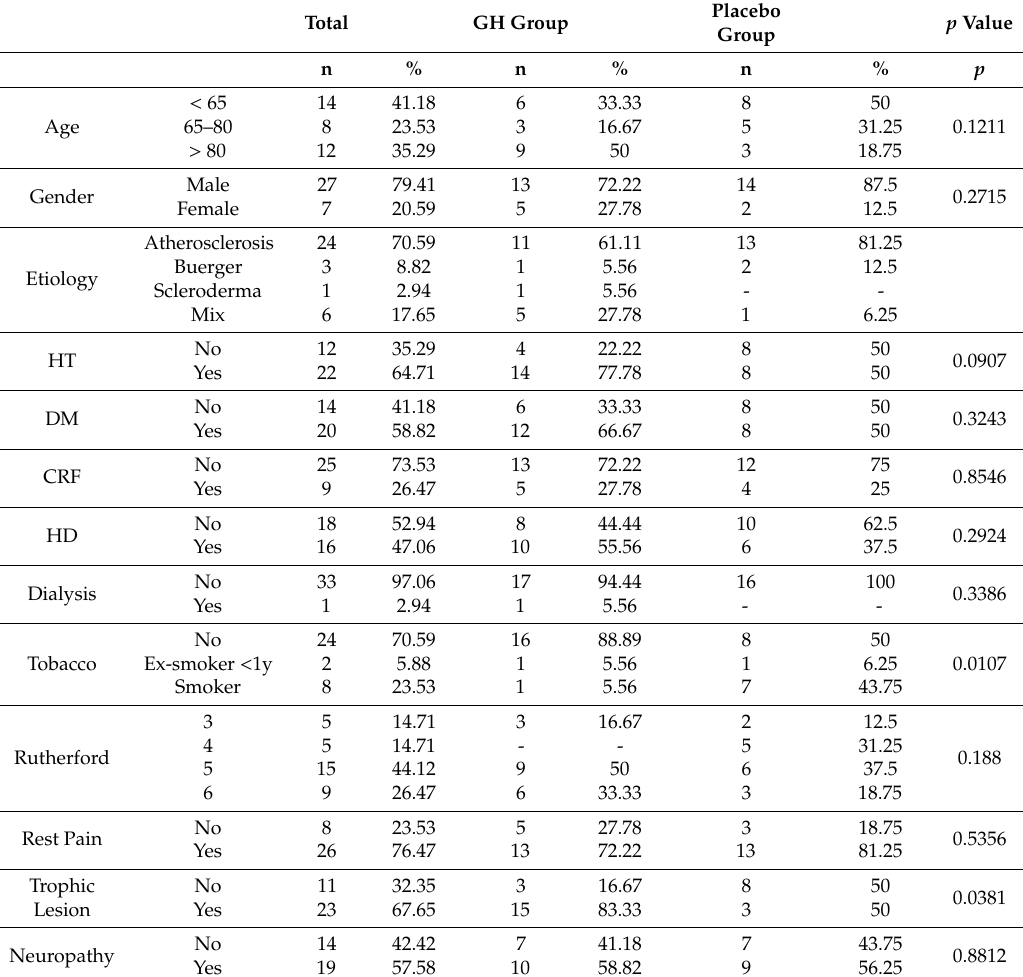
Table 2. Specific characteristics of the patients distributed by treatment groups studied in the GHAS trial. A homogeneous distribution can be seen, except for tobacco consumption. HT: arterial